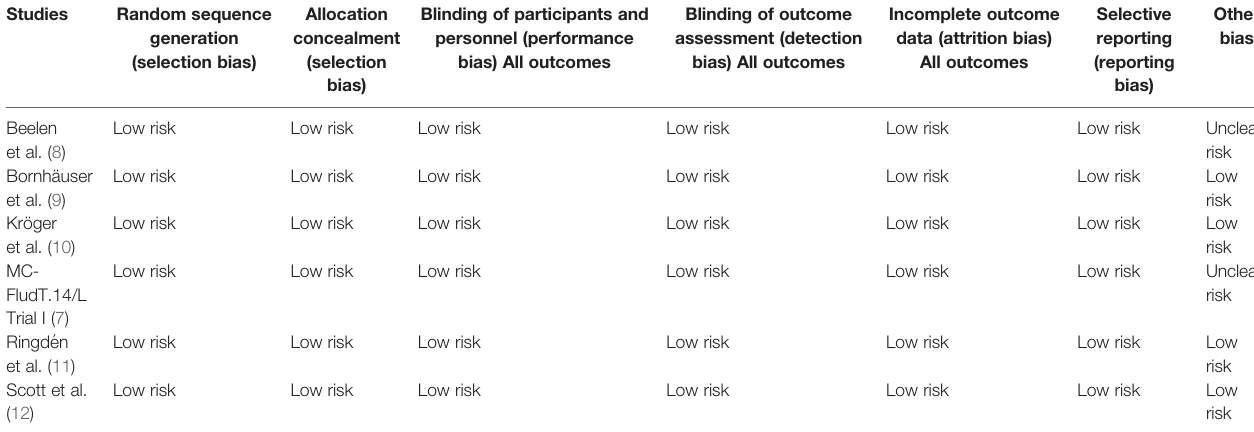
TABLE 2 | Quality assessment of included